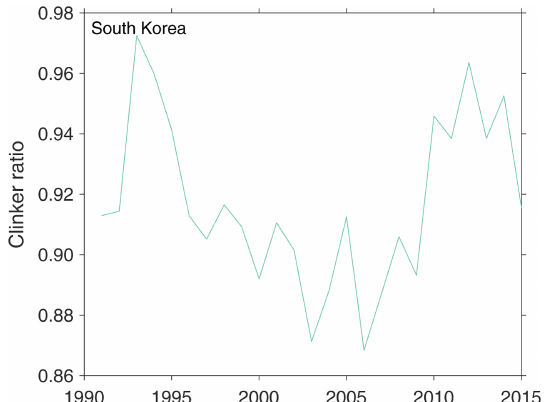
Figure D20. Indonesian clinker ratio calculated from both clinker production and consumption data.